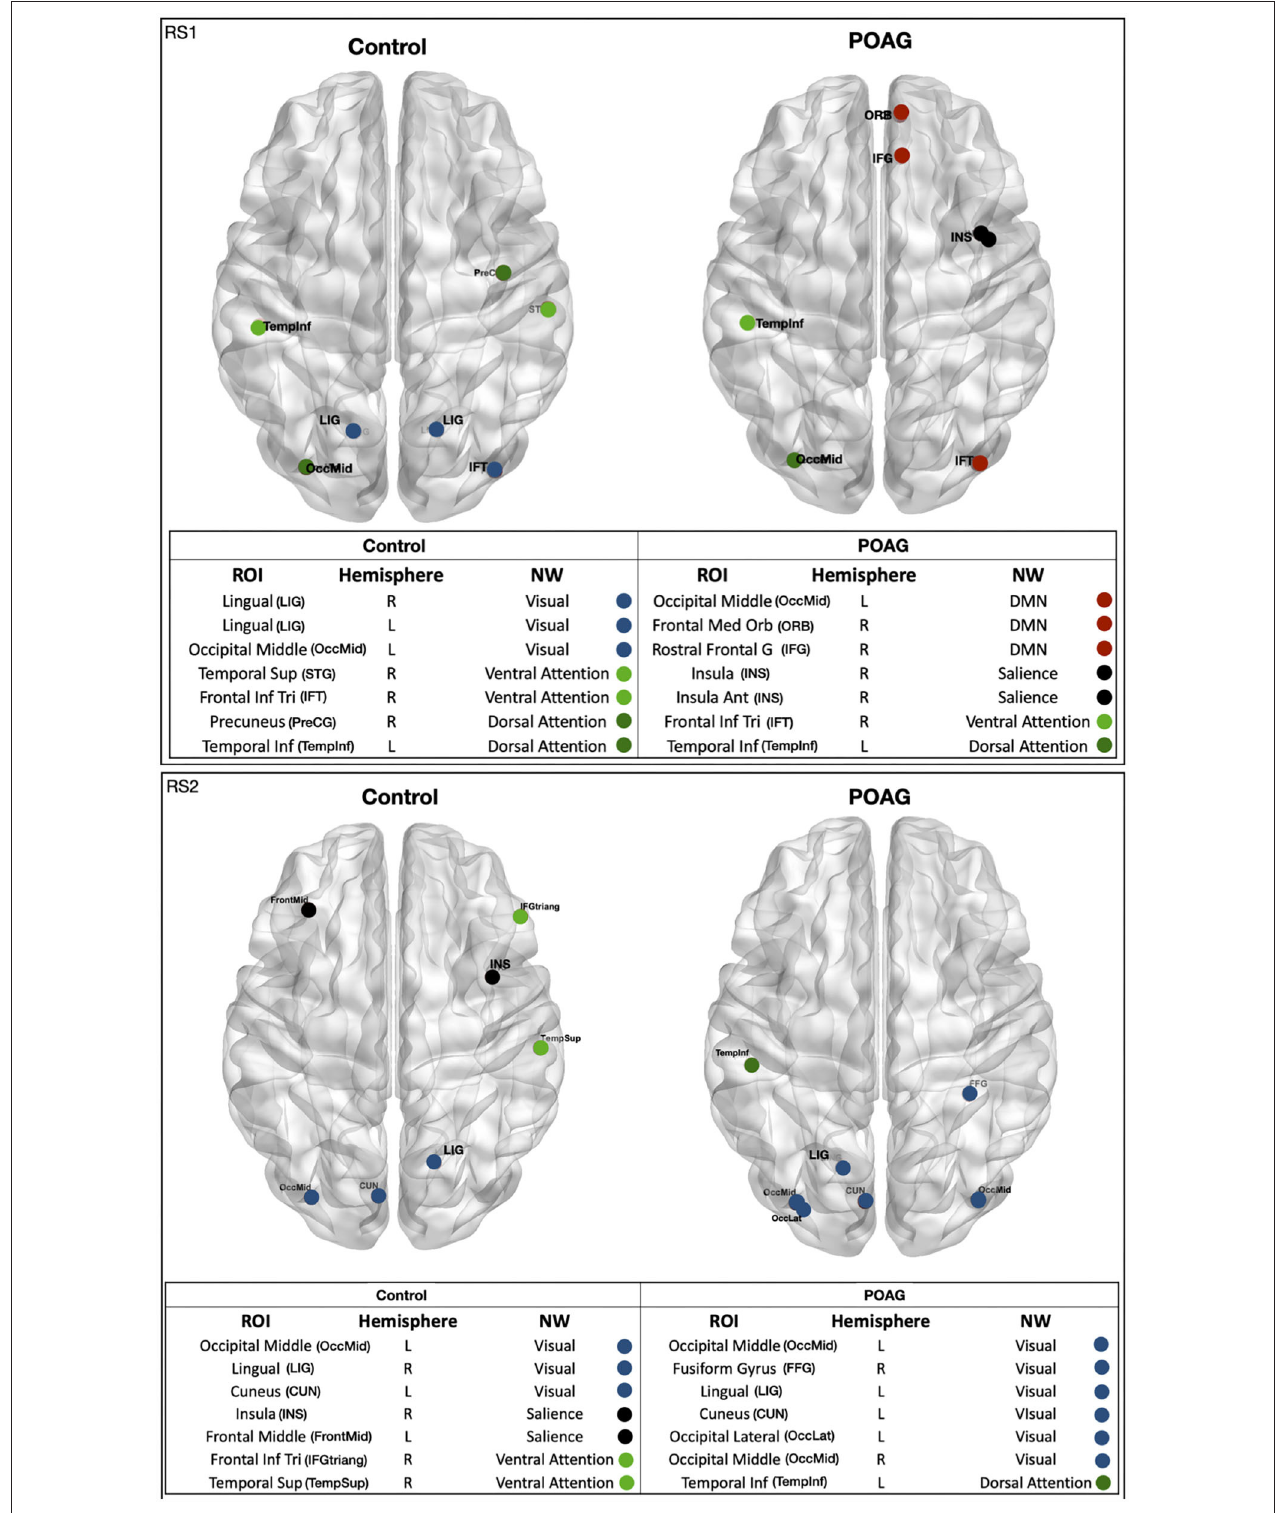
FIGURE 3 | Functional network hubs identified in either of the two RS scans. The figure shows all identified hubs, i.e. the ROIs with 5% highest eigenvector centrality in either of the RS scans in either group - healthy and POAG participants. The tables below the figures list the full name of the ROI, the ROI’s hemisphere, the